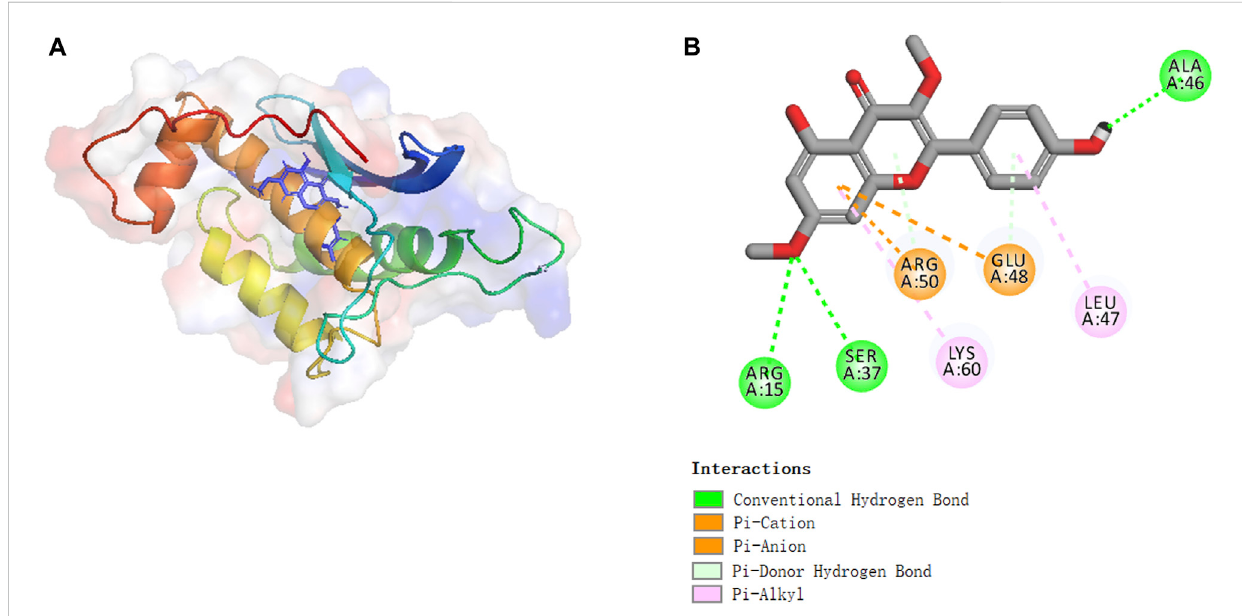
effect could be reversed by kumatakenin. Knockdown of Eno3 signi fi cantly blocked kumatakenin-exerted regulation of IRP1 (Figure 6G), indicating kumatakenin inhibited IRP1 expression by activating Eno3. Furthermore, knockdown of Eno3 signi fi cantly abolished kumatakenin-mediated regulation of iron and lipid reactive oxygen species (ROS) levels in epithelial cells; these effects were reversed by genetic knockdown of IRP1 (Figures 6H, I). Taken together, these data ferroptosis in epithelial cells by regulating the Eno-3-IRP1